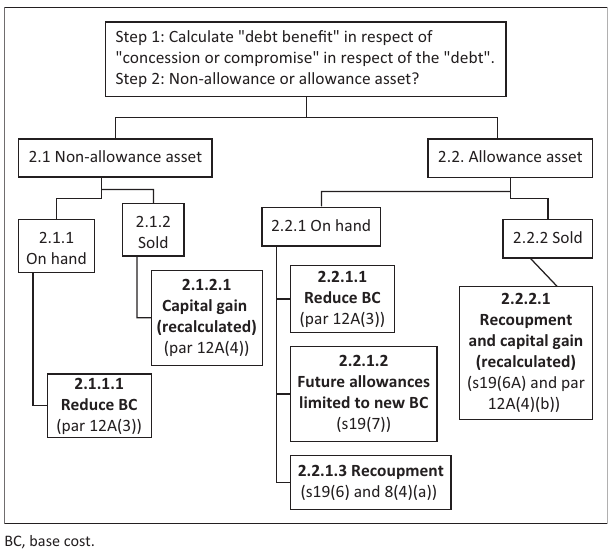
FIGURE 2: Debt funded a capital